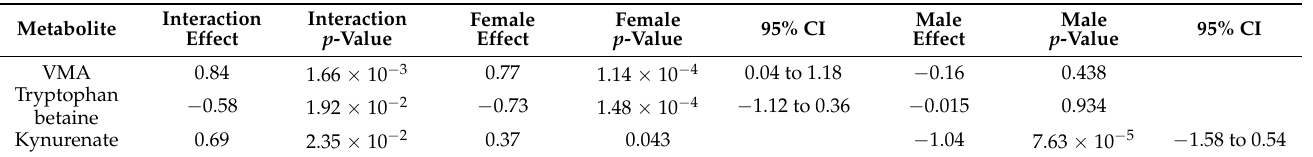
Table 2. Association results for metabolites in relation to diagnosis (AD/CTL) in the full cohort and after stratification by